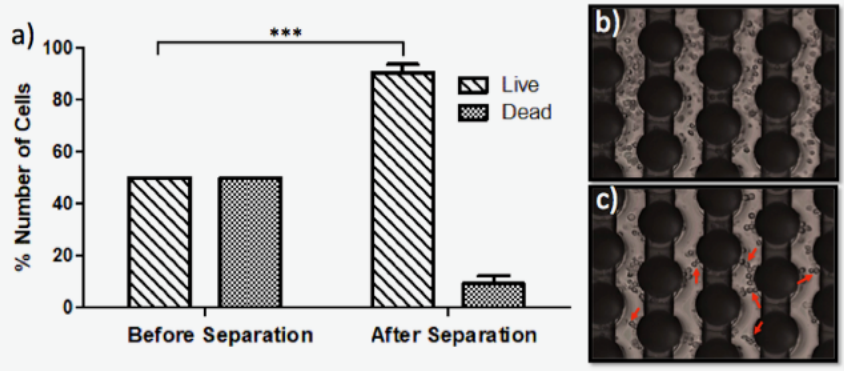
Figure 5. Separation of the live and dead U937 monocytes using 3D carbon-DEP chip. ( a ) the live and dead cell ratio was 1:1 in the cell culture prior to separation. Upon the separation, 90% of the dead cells were removed; ( b ) the images show the cells on the 3D carbon array before the separation and ( c ) after separation. The separation conditions: 20 Vpp, 300 kHz, 1 µ L/min flow